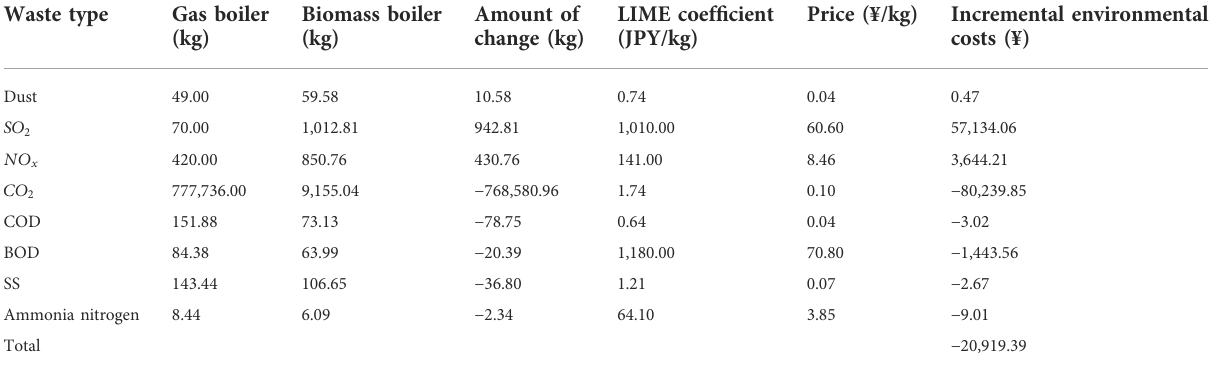
TABLE 10 Emissions of gas boilers/biomass boiler and incremental environmental